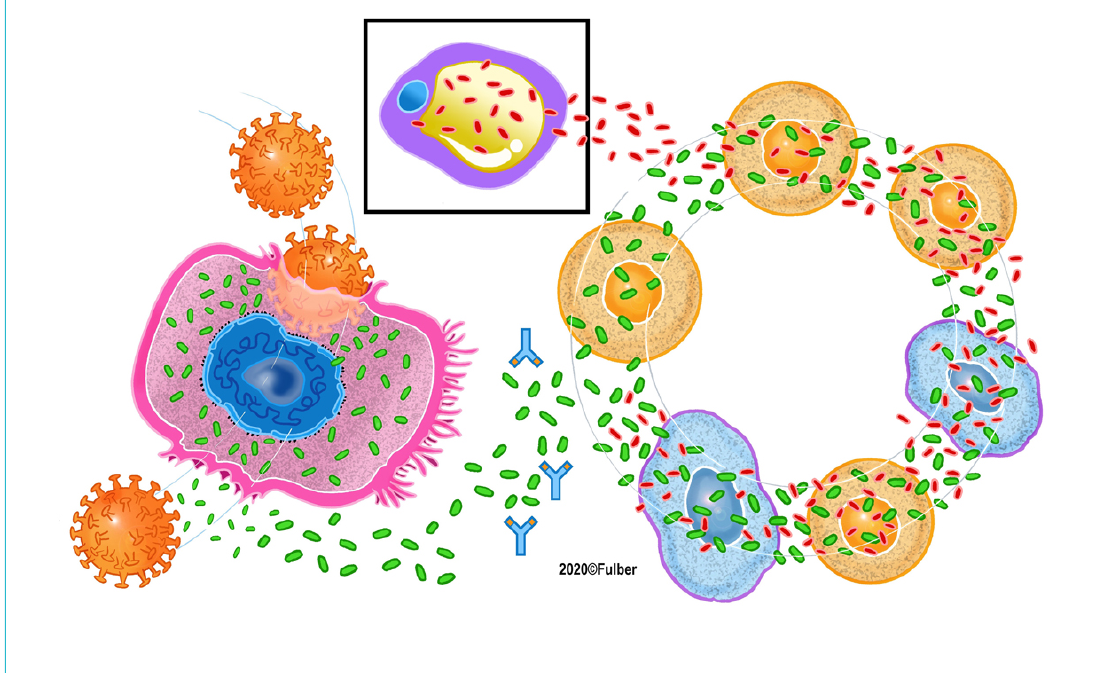
Figure 1: The vicious circle obesity-inflammation-virus . The coronavirus enters the lung cell (left) and causes the release of a large quan- tity of inflammatory cytokines (green ovals) which set off a pinwheel of immune system cells, lymphocytes and monocytes, which are activated among themselves, forgetting about the virus. From the adipose tissue (in the square above) the adipocyte discharges its adipokines (red ovals) into the system, which increase the inflammatory response that damages the lung. The same thing happens in all organs whose